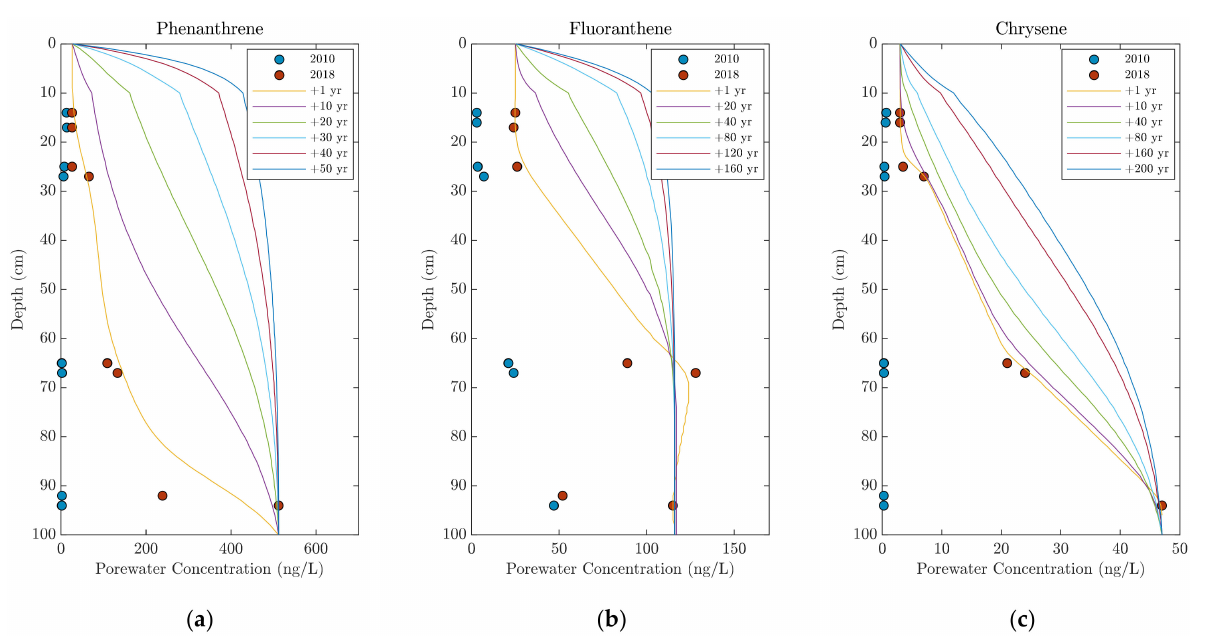
Figure 7. Depth-profile porewater concentrations from 2010 (blue circles) and 2018 (red circles) of ( a ) phenanthrene, ( b ) fluoranthene, and ( c ) chrysene at sampling location #20. Each graph has modeled contaminant transport through the cap based on the calculated mass-transfer coefficient, k , and upwelling velocity, U z , of the d-PAH performance reference